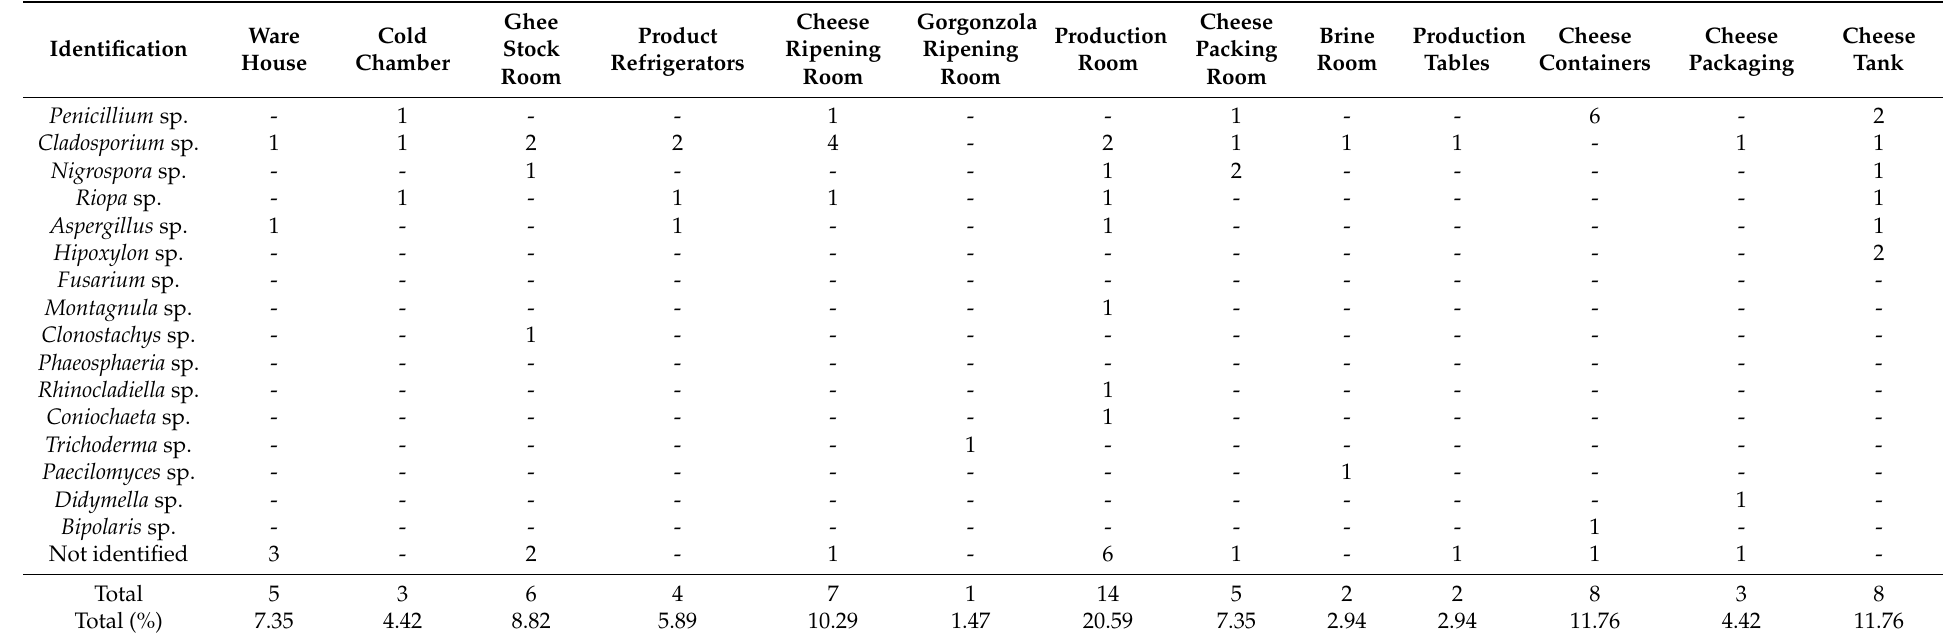
Table 2. Diversity of spoilage fungi isolated from dairy environments (factory air, equipment and tools).